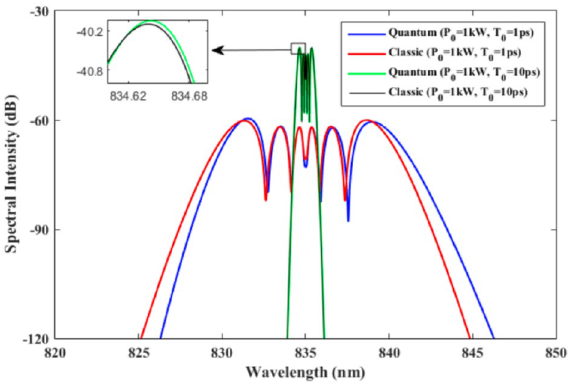
Figure 4. The propagation of light pulses at 1 kW, low power, and pulse width of 1 ps and 10 ps are compared for both classical and quantum mechanical models. Inset shows details of the spectrum in a region of the